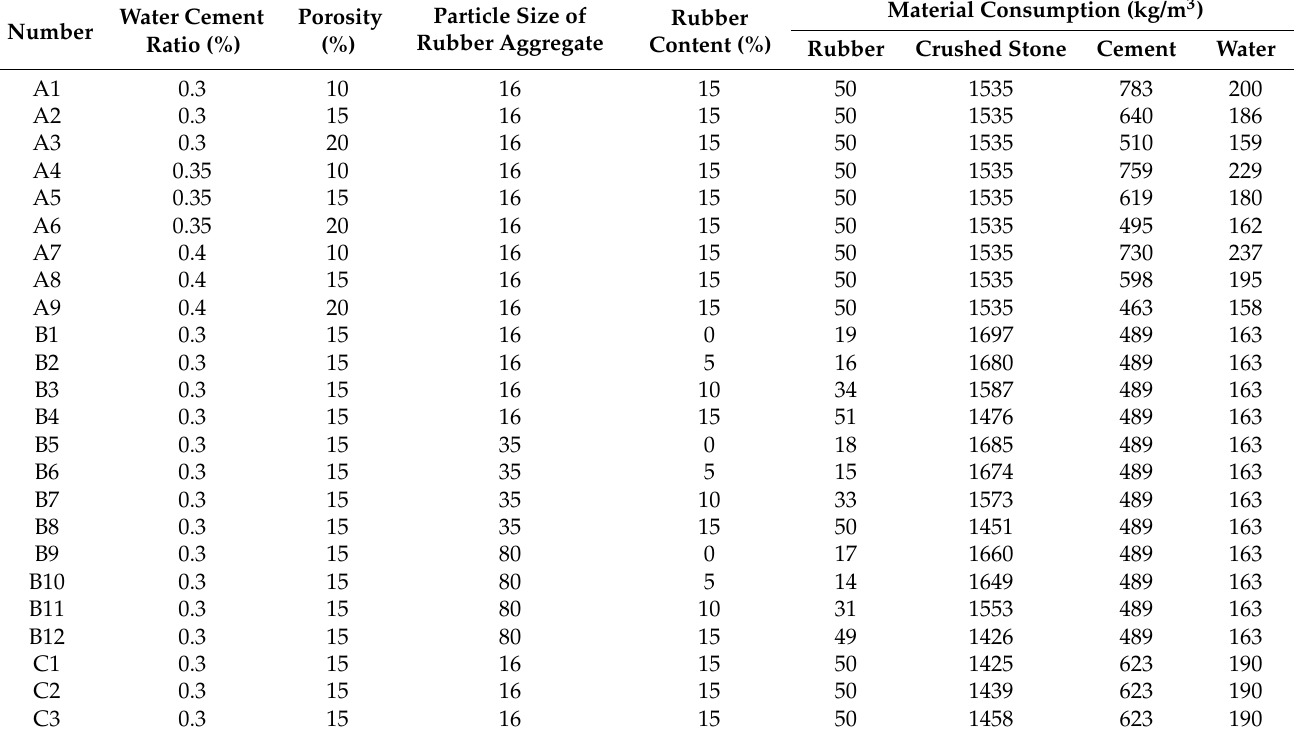
Table 3. Material consumption of past concrete with one cubic meter of rubber